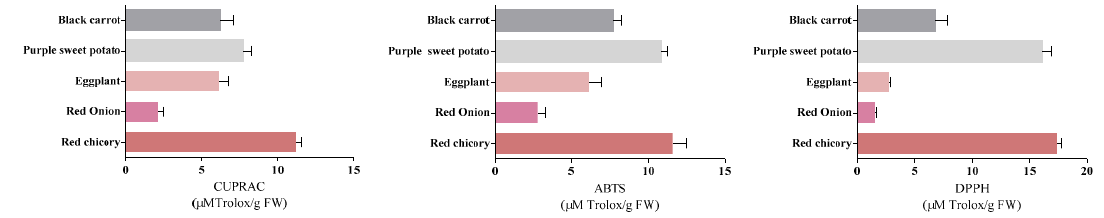
Figure 2. Antioxidant capacity of selected vegetables (values are expressed as µ M Trolox / FW). From the highest to the lowest, the order of the samples that were used in this study based on the antioxidant activity was red chicory > purple sweet potato > black carrot > eggplant > red onion.